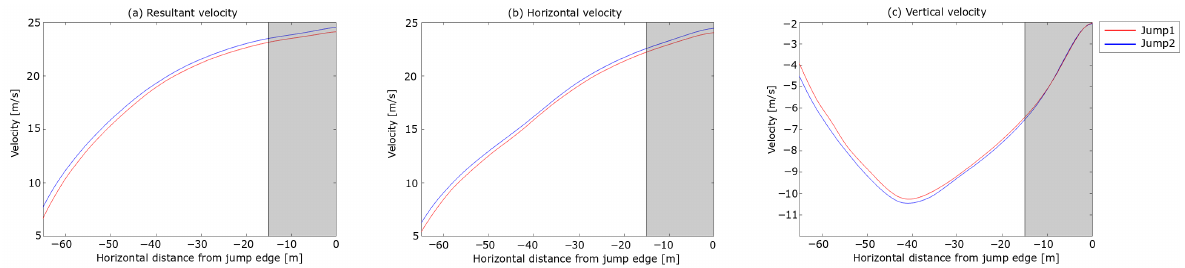
Figure 6. Velocity components of the in-run phase for the two jumps in the case analysis. ( a ) shows the resultant velocity v , ( b ) the horizontal velocity v x and ( c ) the vertical velocity v y . The horizontal length from the in-run edge is shown on the x-axis and velocity is shown on the y-axis.